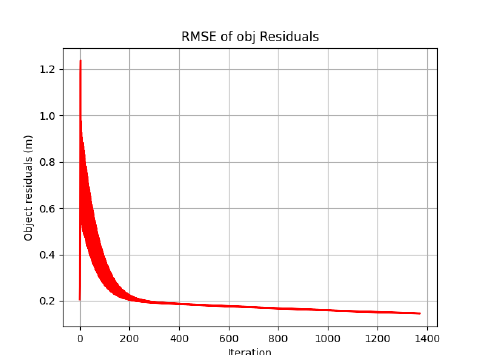
Figure 6. Displaying RMSE of object residuals in Bundle adjustment